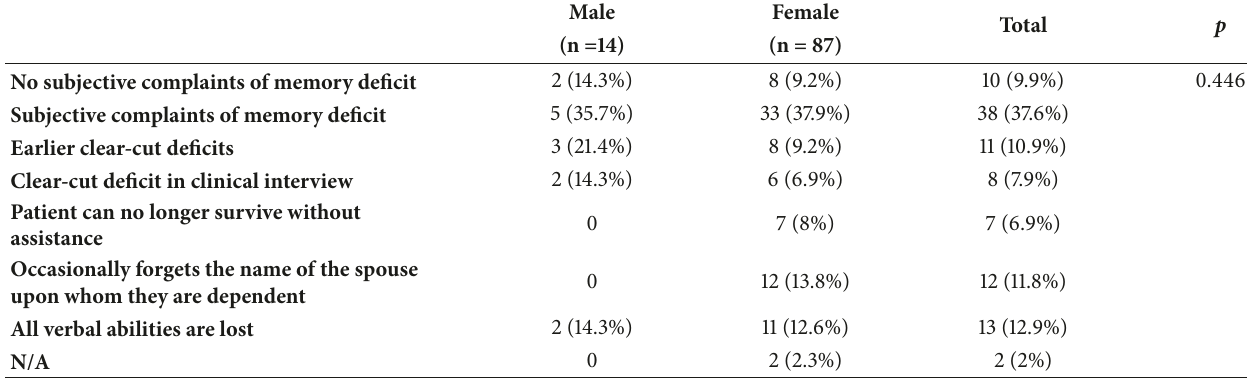
Table 4: Global Deterioration Scale of the Portuguese centenarians from Beira Interior ( 𝑁 =